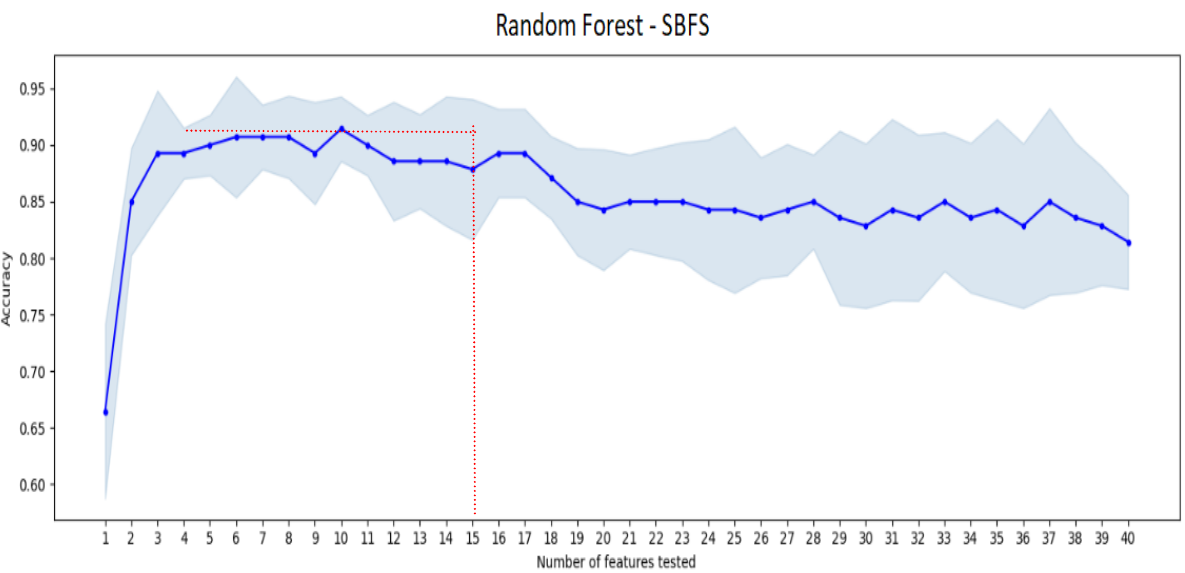
Figure 8. GWO-SVM classification accuracy score according to the sub-vector of tested features us- ing SFFS algorithm.